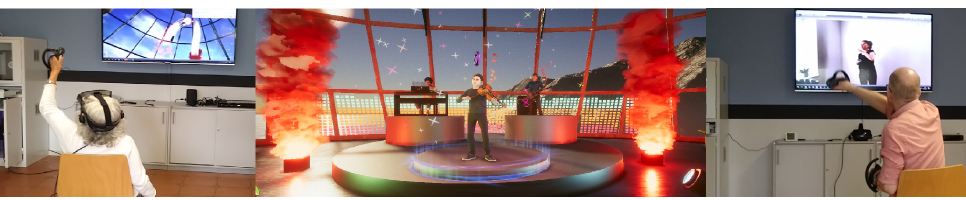
Figure 3. Left: An older adult playing Maestro Game VR . Middle: The virtual stage. Right: An older adult doing his workout with the 2D